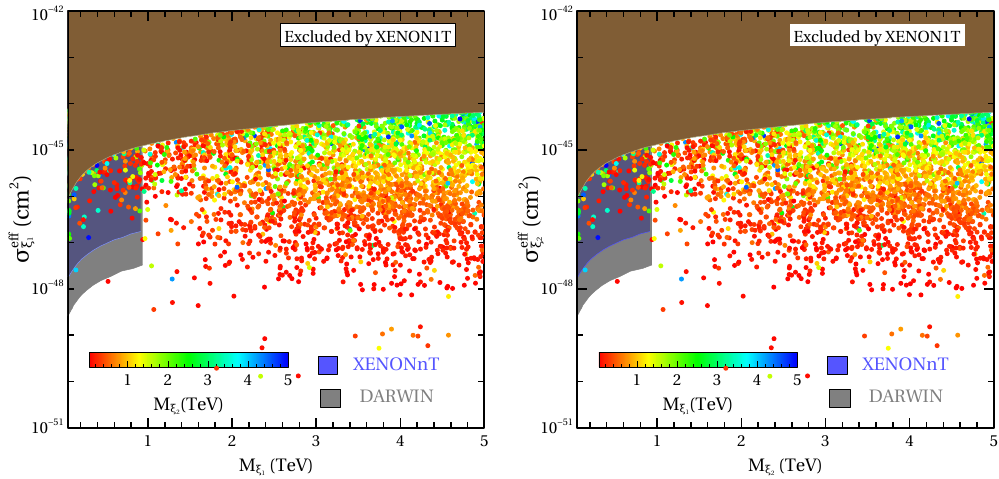
Figure 9 . E(cid:11)ective spin-independent scattering cross section o(cid:11) nucleons for individual DM can- didates. All the points satisfy total DM relic, perturbativity, bounded from below criteria of the scalar potential. The projected sensitivities of XENONnT (blue region) and DARWIN (gray region) experiments have been shown in both the plots.